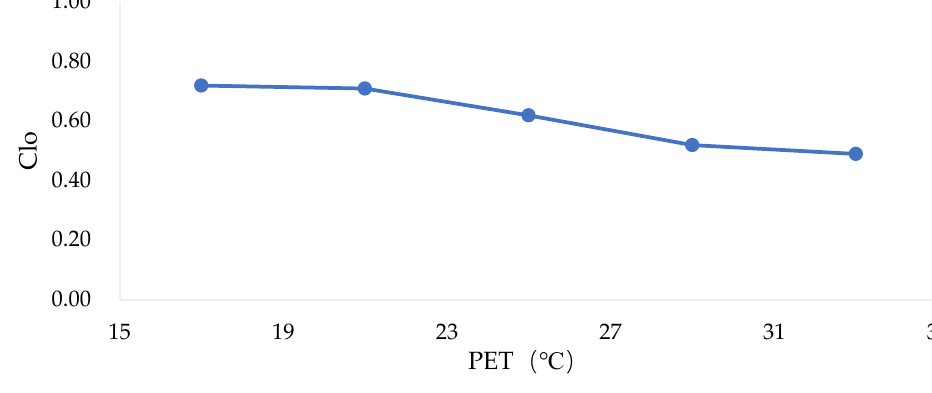
Figure 12. Relationship between clothing insulation and PET.